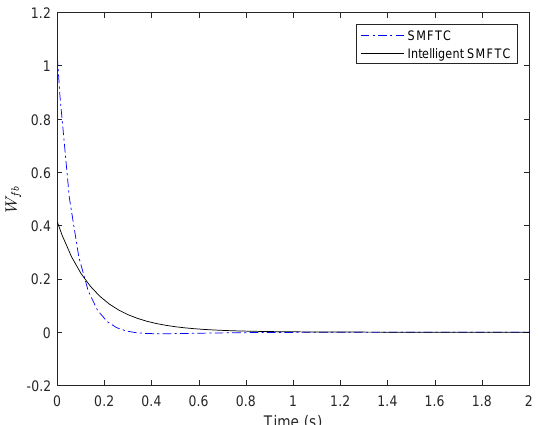
Figure 14. Normalized deviation of fuel flow ratio.